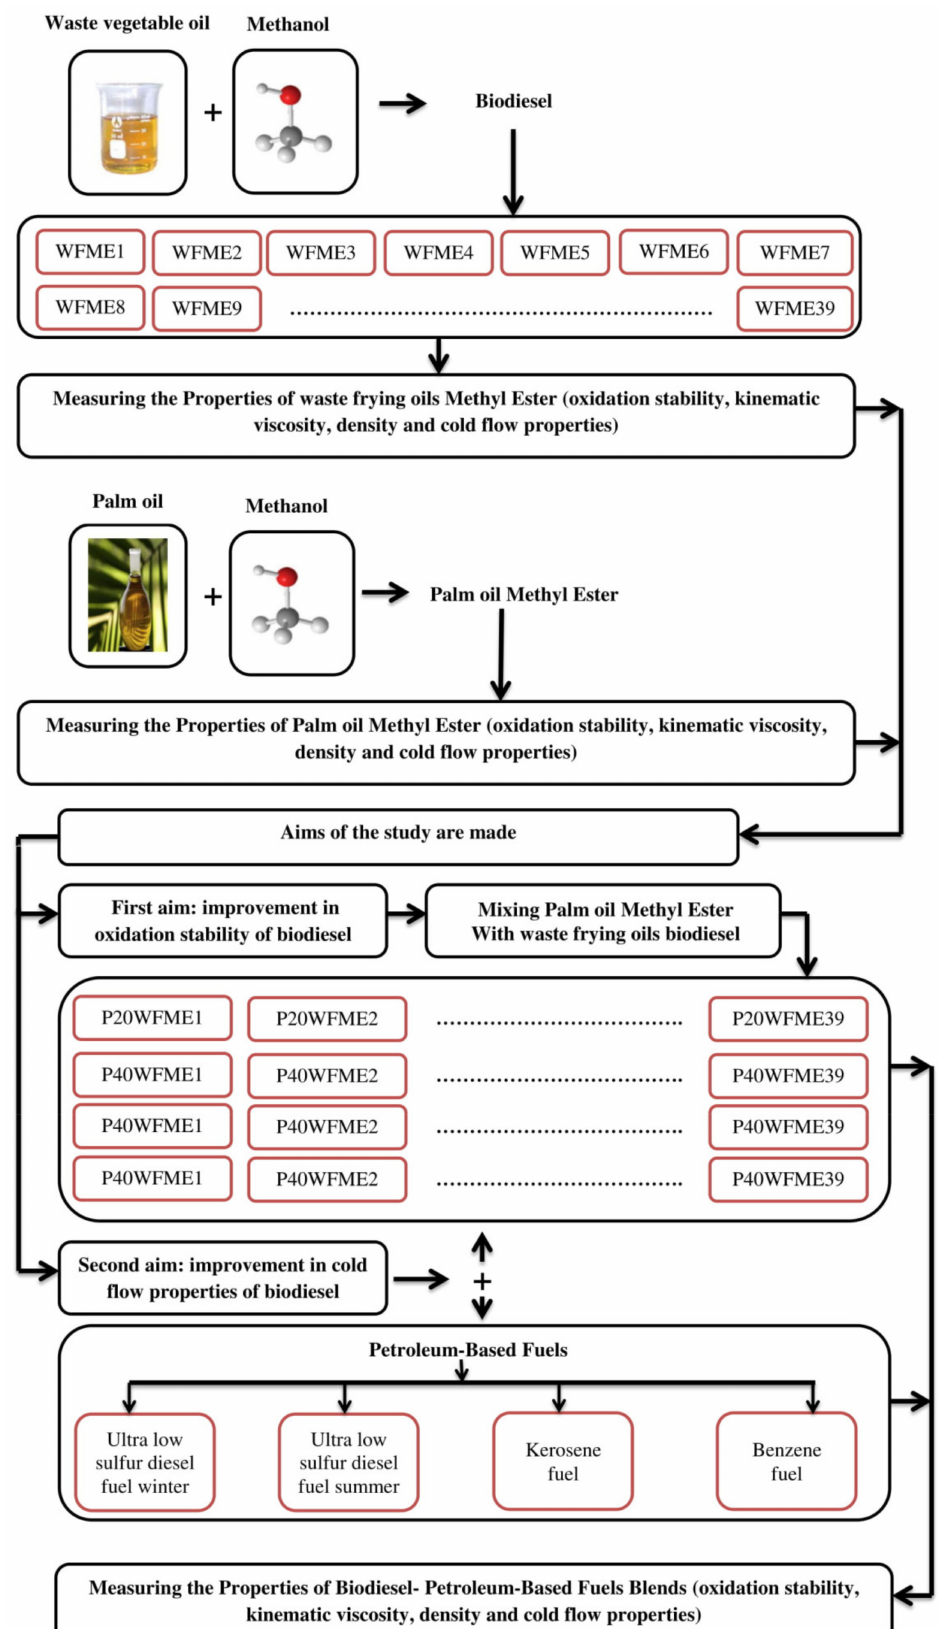
Figure 1. Schematic description of the proposed